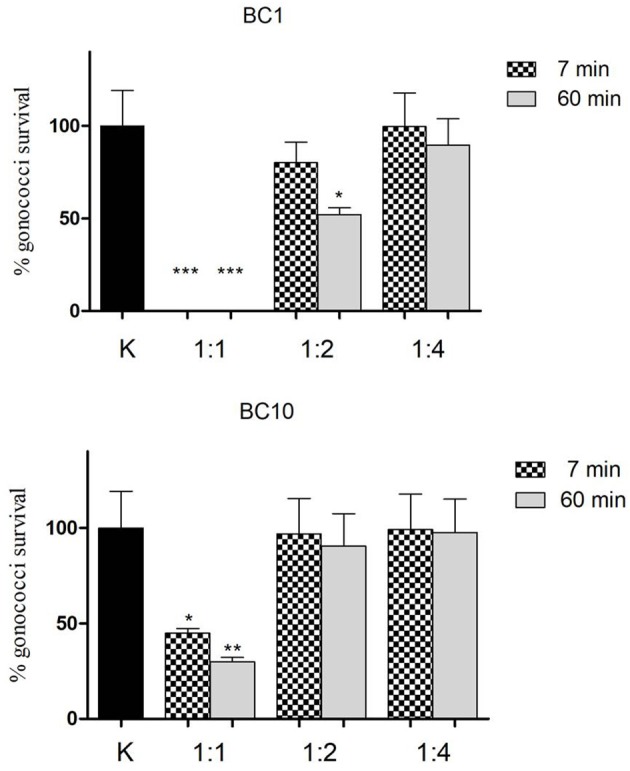
Effect of lactobacilli RSC on GC viability. “Inhibition” experiments against GC were performed with released surface components isolated from L. crispatus BC1 (BC1) and L. gasseri BC10 (BC10). Three different dilutions of RSC were tested (1:1, 1:2, and 1:4) at two different time points (7 min-dotted bars and 60 min-gray bars). GC viability was evaluated as number of gonococci/mL and expressed as % of gonococci survival. The results were expressed in percentage compared to control (K) (1 × 108 gonococcal cells incubated in PBS), taken as 100% (black bar). Bars represent mean values, whereas error bars represent SEM. Statistical significance was determined at *P < 0.05, **P < 0.01, and ***P < 0.0001.